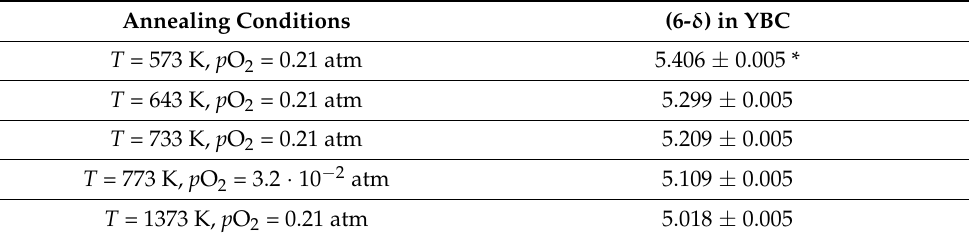
Table 1. The annealing conditions and the oxygen content in the quenched YBC samples. Annealing